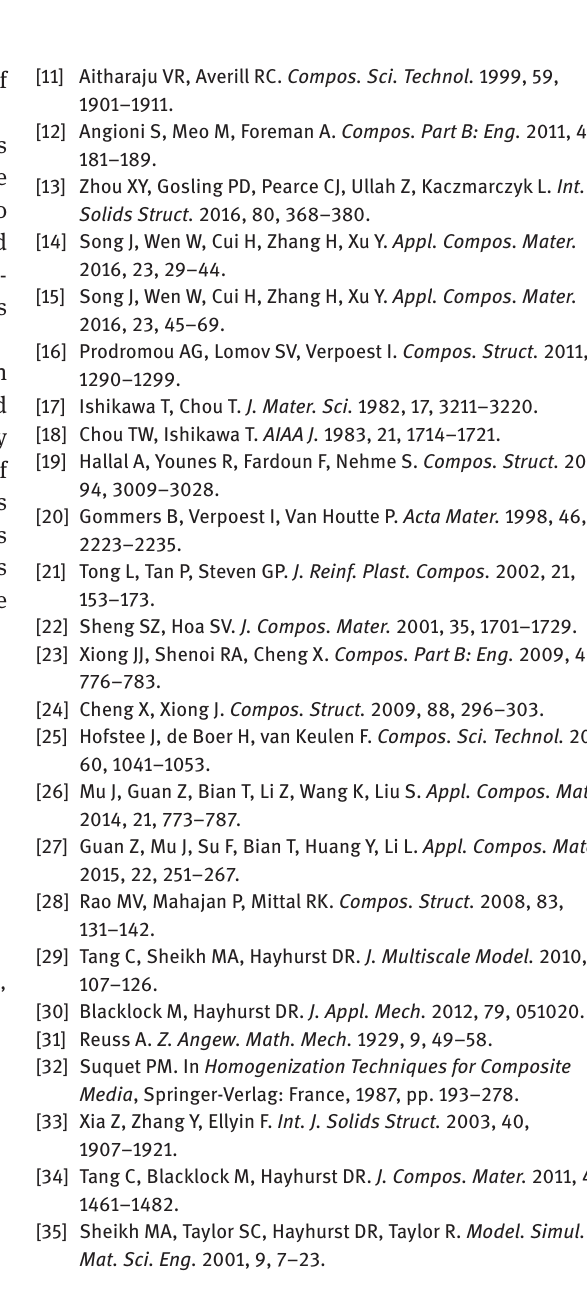
Figure 25: Stress nephogram of two models under σ (A) Stress nephogram of RUC model. (B) Stress nephogram of ORUC